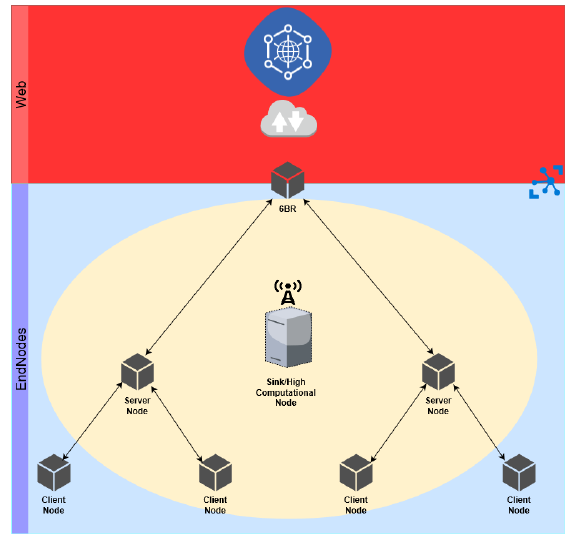
Figure 1. Architecture for intrusion detection in the context of Internet-integrated CoAP sensor